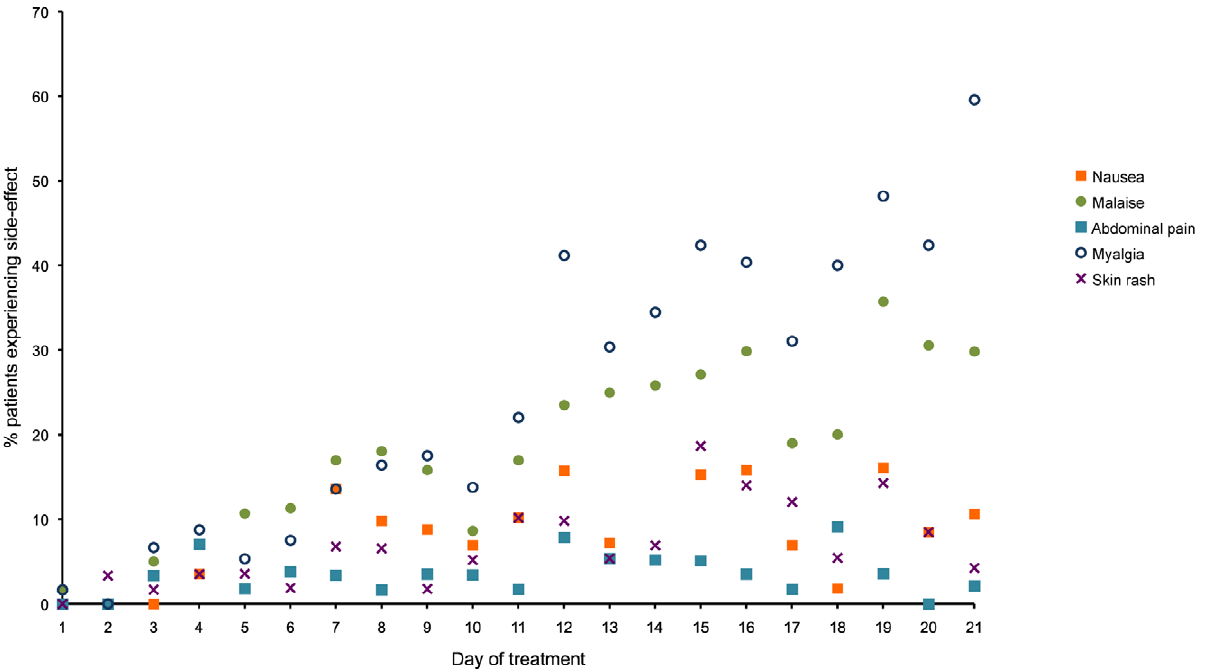
Figure 4. Percentage of patients reporting side-effects on each day of treatment with sodium stibogluconate (SbV).